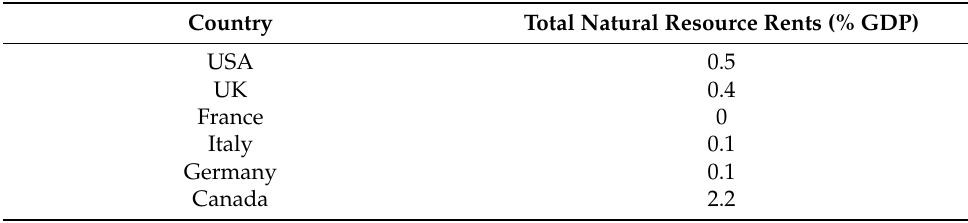
Table 8. Total natural resource rents (% of GDP) in 2020. Country Total Natural Resource Rents (%